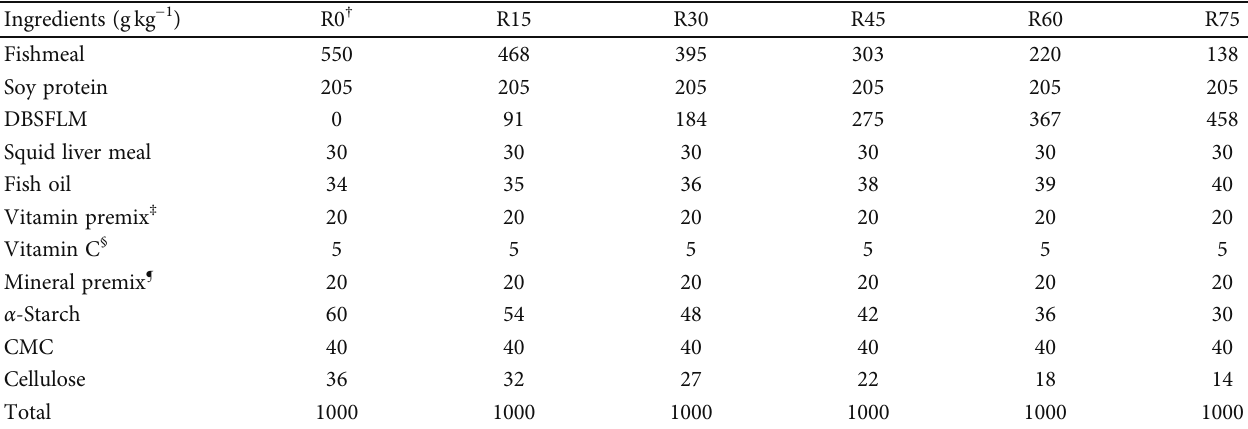
Table 2: Formulation of experimental